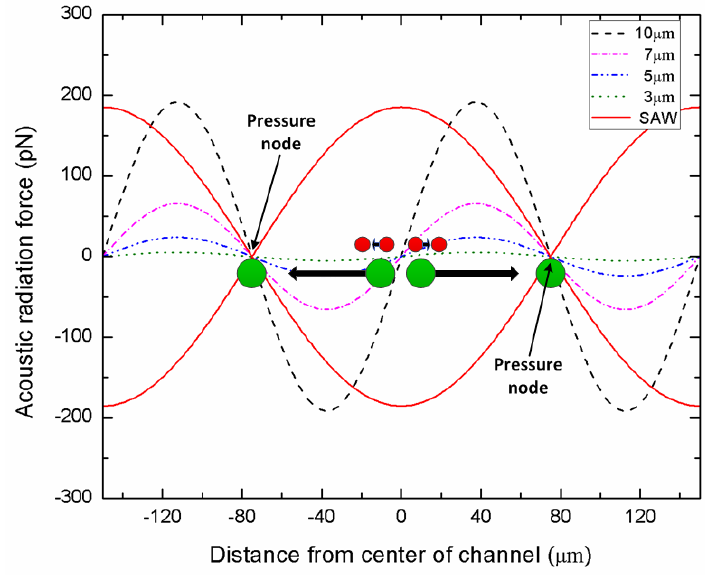
Figure 2. The distribution of acoustic radiation forces within the 2nd stage